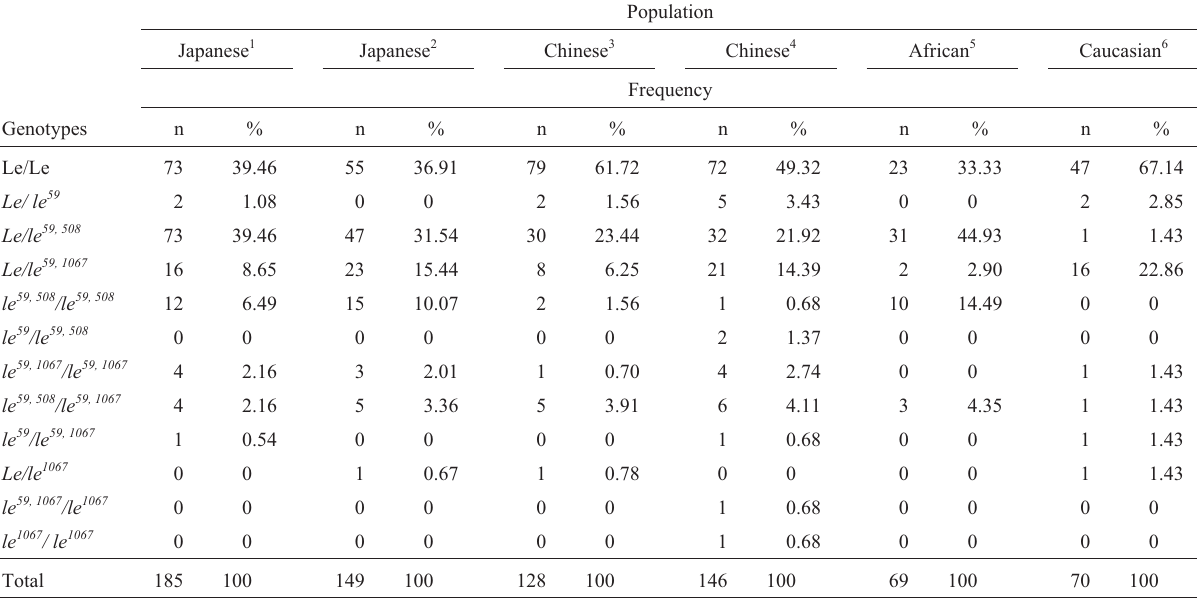
Table 4 - Comparison of the genotype frequencies of the three FUT3 gene SNPs analyzed in the current study (n = 185) and in other populations described in the literature. The le 59 genotype represents the FUT3 59G allele while le 59,508 represents the association of the FUT3 59G and FUT3 508A alleles on the same chromosome and le 59, 1067 the association of the FUT3 59G and FUT3 1067A alleles on the same